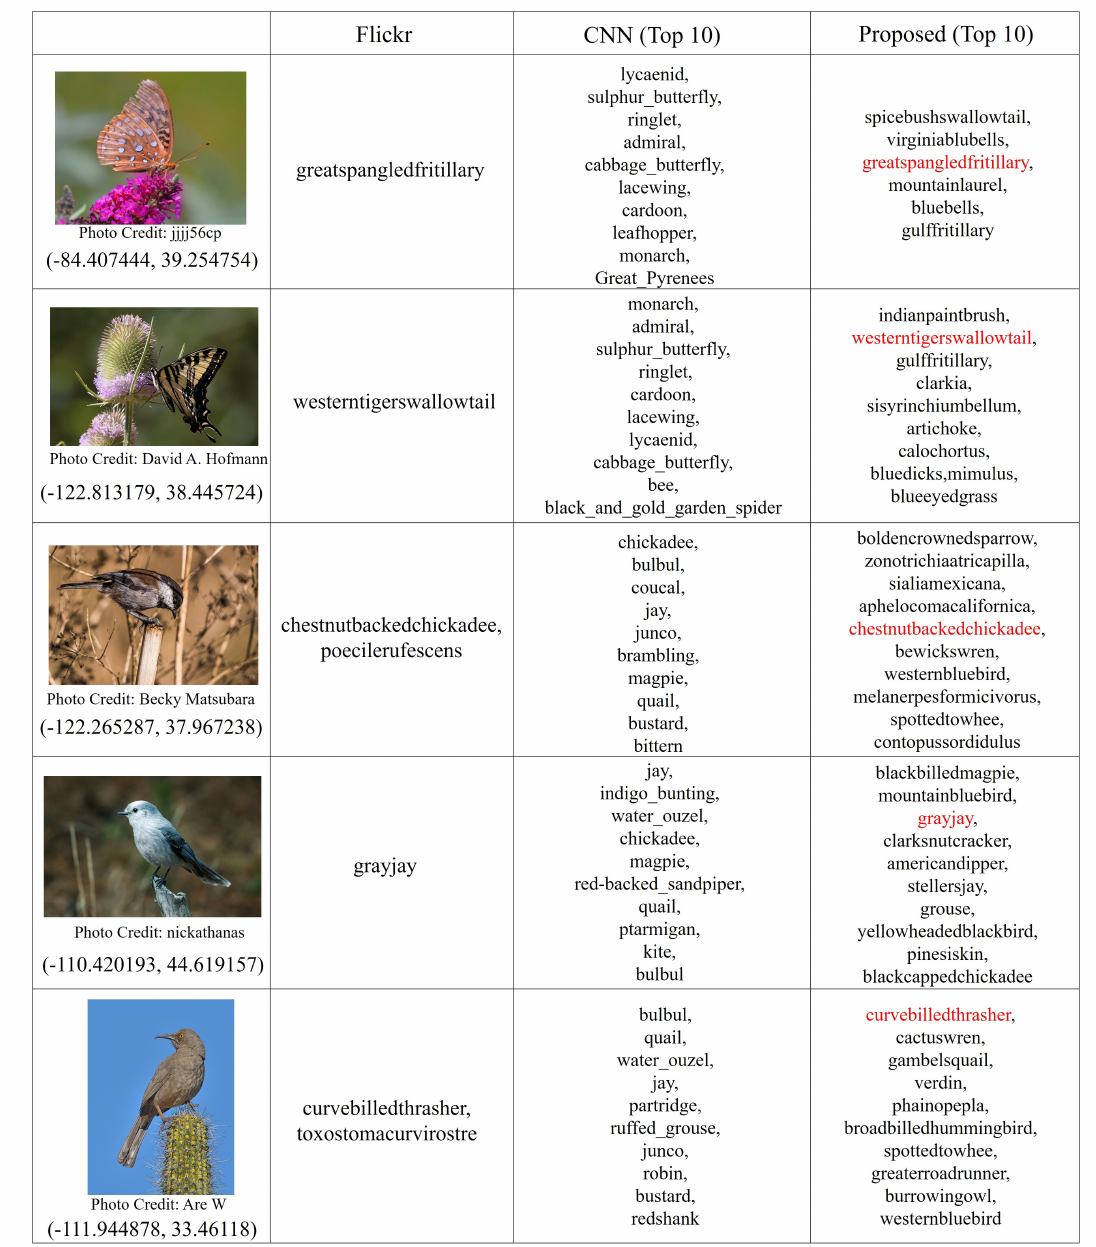
Figure 19. Examples of image recognition results for visually similar test images captured at different